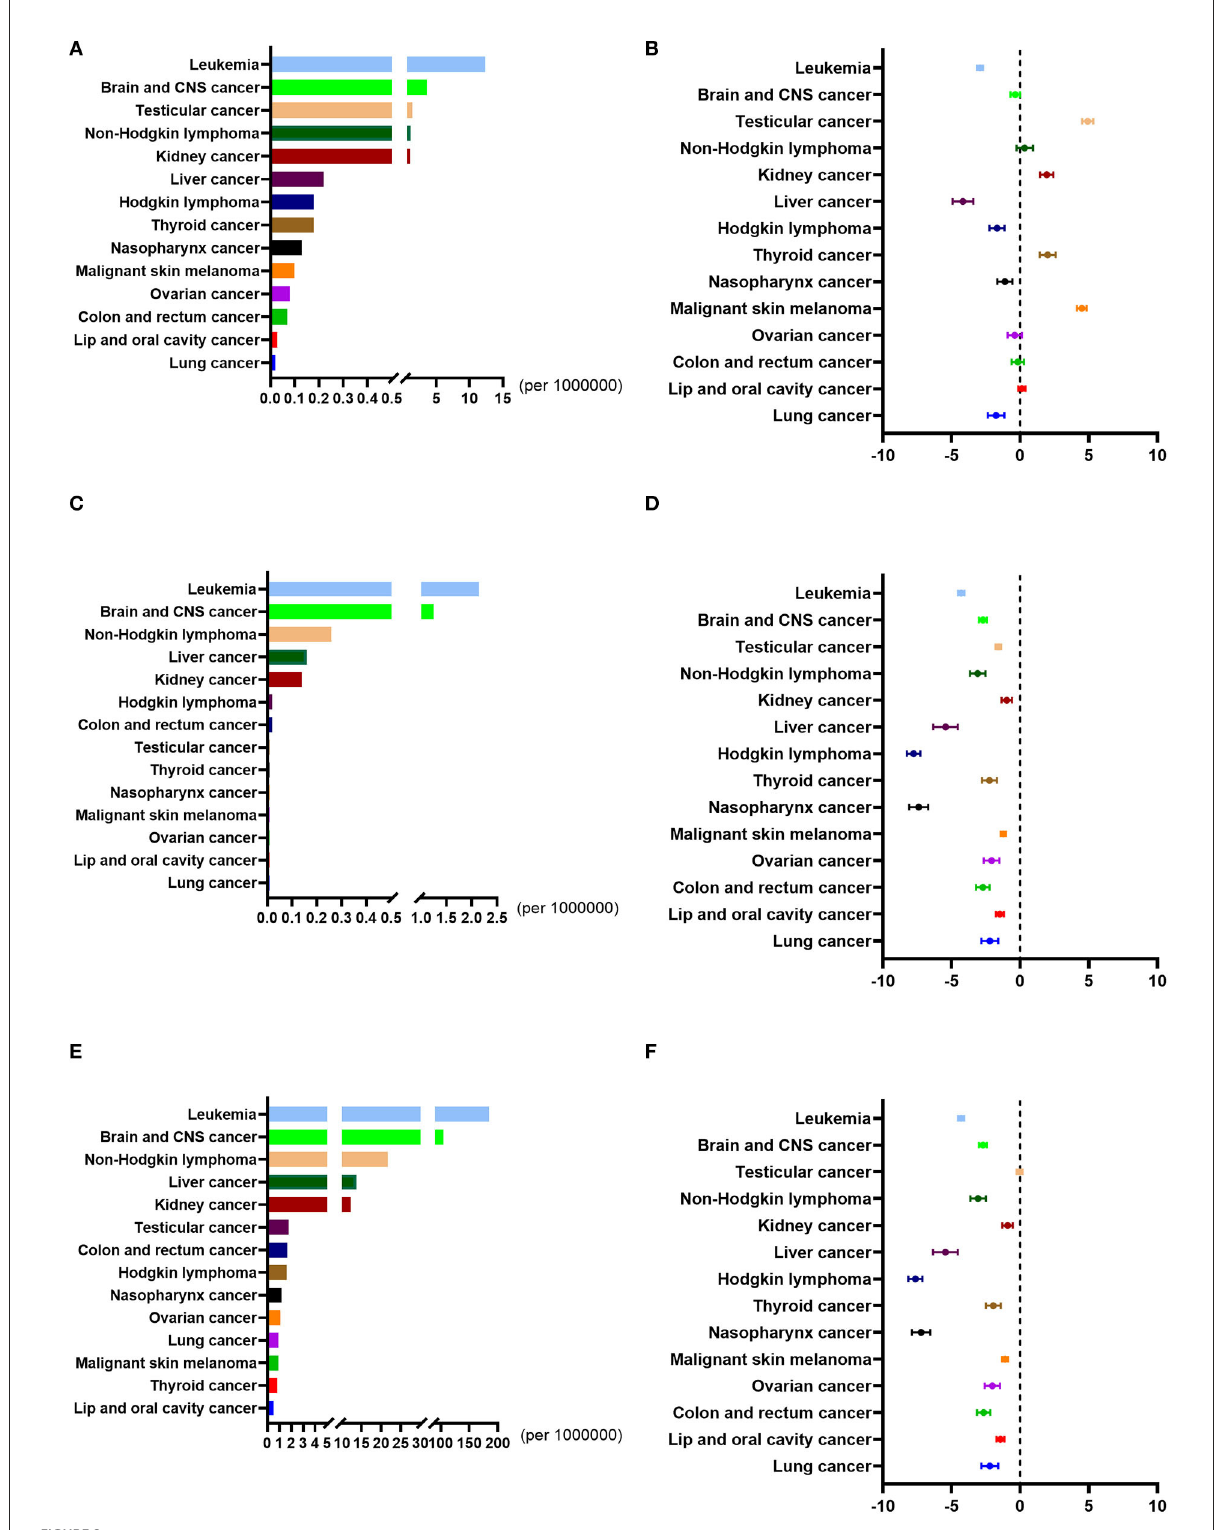
FIGURE2 Incidence rates, mortality rates, and DALY rates of all the childhood cancers in China from 1990 to 2019. (A) The incidence rates of all the childhood cancers in China in 2019. (B) The average annual percentage change (AAPC) in the incidence rates of all the childhood cancers in China from 1990 to 2019. (C) The mortality rates of all the childhood cancers in China in 2019. (D) The average annual percentage change (AAPC) in the mortality rates of all the childhood cancers in China from 1990 to 2019. (E) The DALY rates of all the childhood cancers in China in 2019. (F) The average annual percentage change (AAPC) in the DALY rates of all the childhood cancers in China from 1990 to